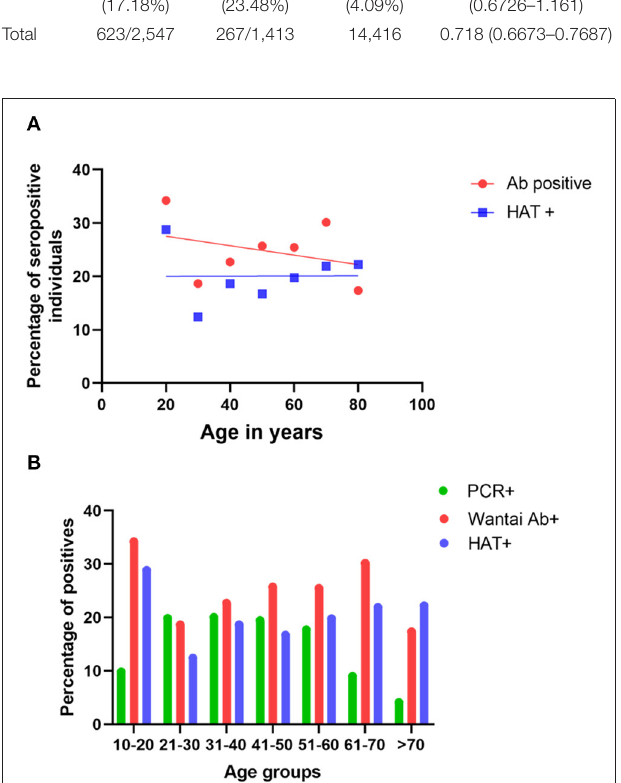
FIGURE 2 | Seropositivity rates and infection rates in different age groups. The seropositivity rates were assessed in each age group by the Wantai total antibody assay (Wantai Ab + ) and the HAT assay (HAT + ), and the positivity rates of each assay were correlated with the age (A) . The PCR positivity rates in each age group and the Wantai (Ab + ) and HAT (HAT + ) positivity rates were compared in each age group (B)